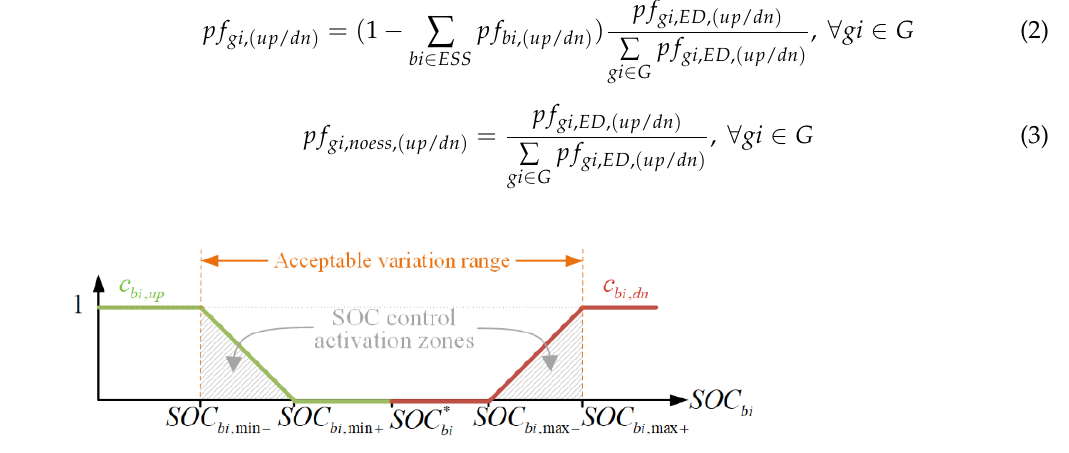
Figure 2. Calculation of c bi,up and c bi,dn parameters.